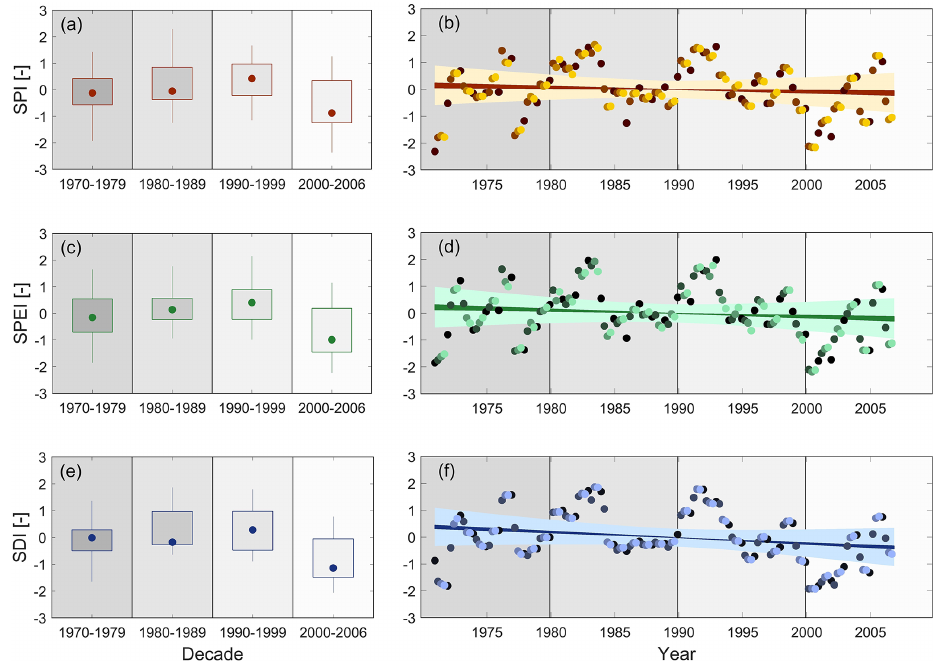
Figure 7. Decadal distributions and time series of mean basin (a–b) SPI, (c–d) SPEI, and (e–f) SDI over the study period. The dots in the box plots indicate the median values and the whiskers the 5th and 95th percentiles. The dark-to-light shaded dots in the time series plots indicate the monthly drought indices (based on 12 months of accumulation time) for January, April, July, and October, respectively. The dark shaded areas indicate the envelope of trend lines for the trends estimated based on January, April, July, and October, respectively. The light shaded areas show the associated envelope of the 5th and 95th confidence